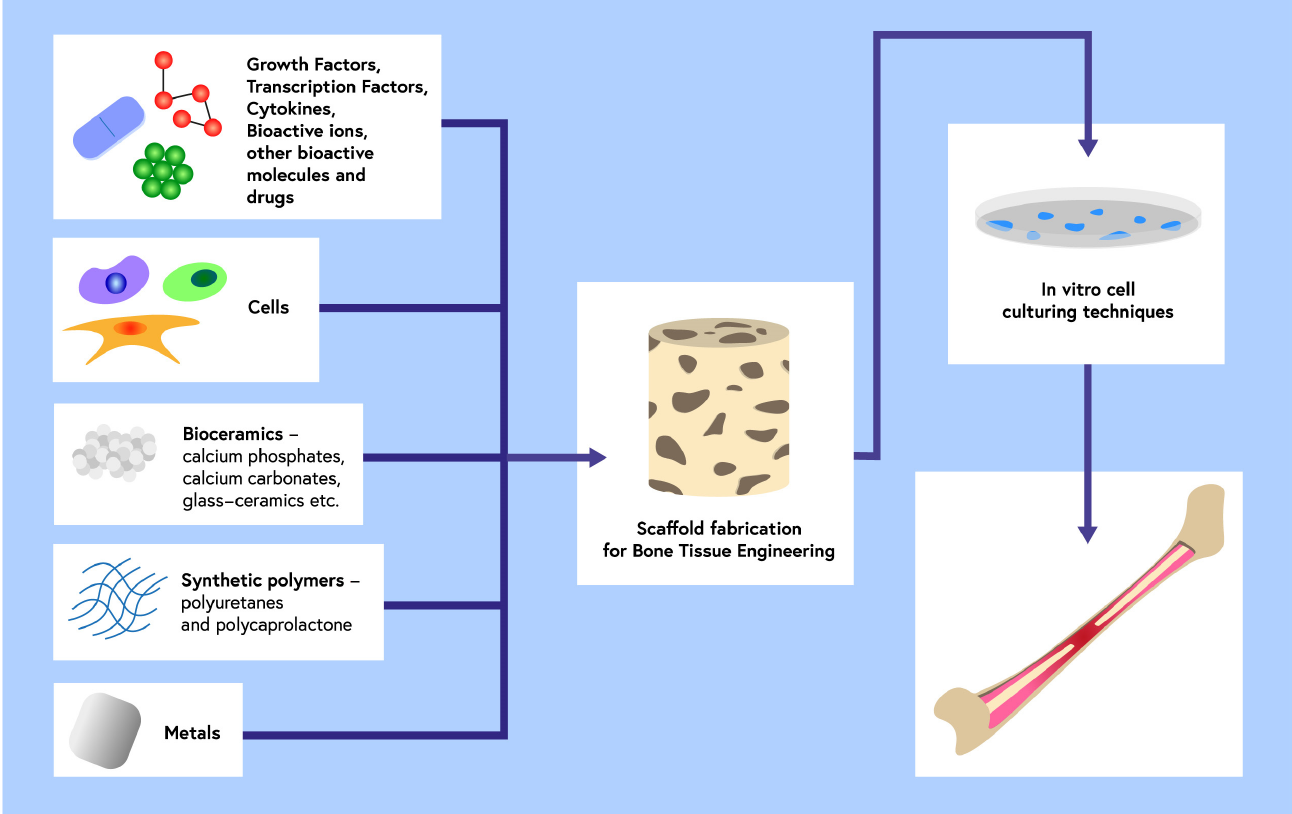
Figure 1. The strategies of bone tissue engineering.